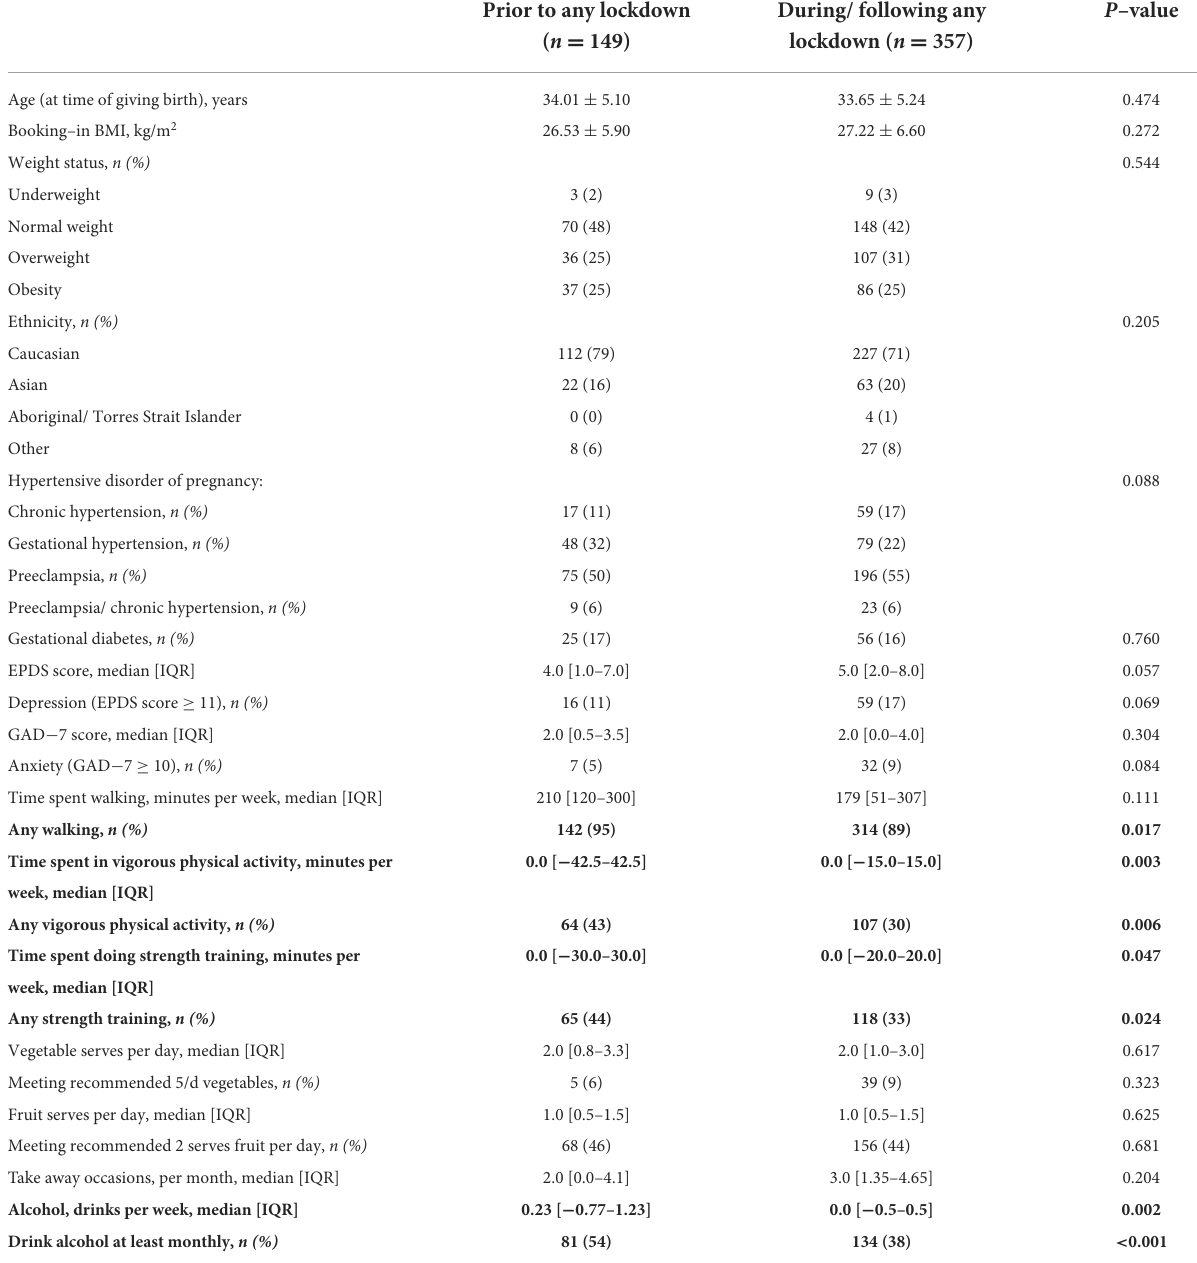
TABLE 2 Characteristics of women at 6–months postpartum participating in the BP 2 study who filled in study questionnaires prior to any COVID − 19 lockdown vs. those during or following any COVID − 19